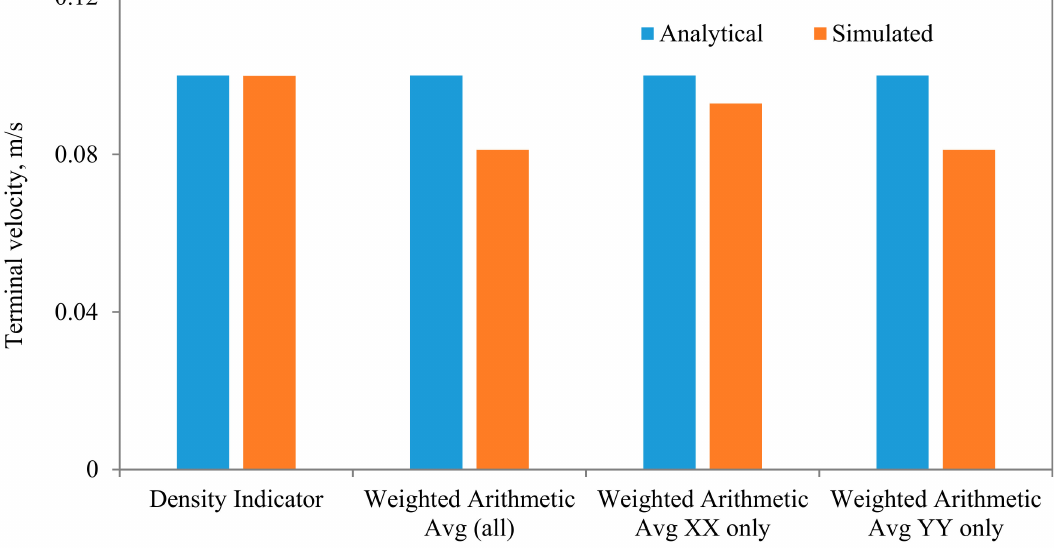
Figure 16. Comparisons between the terminal settling velocity and the simulated one for different algorithms for calcu- lating the density in the cells encompassing the interface. In these simulations, the following parameters are held fixed: k x = d/L x = 4, µ f = 0.001 Pa · s, µ p = 1000 Pa · s, Mesh n x = 40, n y =